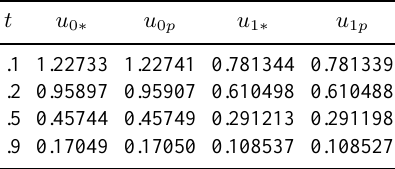
Table 5. The values u (0 ; t ) ; u (1 ; t ) in the time t